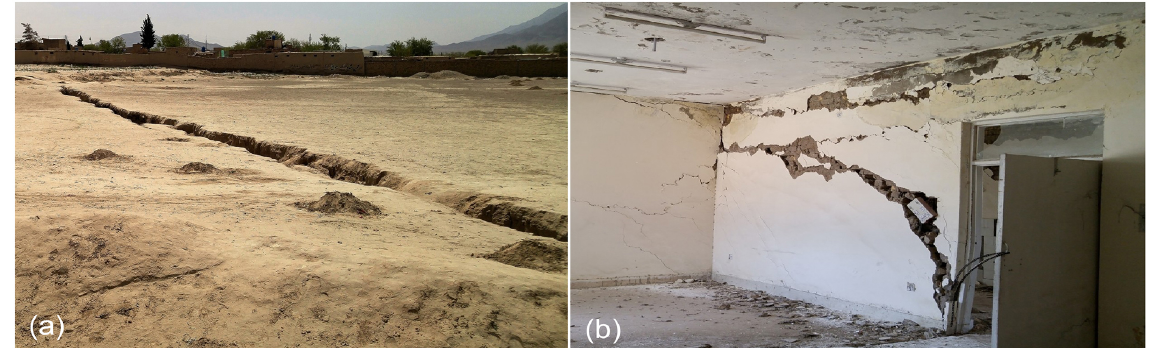
Figure 2. (a) shows the fissures in Kechi Baig area whereas (b) shows the damage that is caused to Dr. Sarfaraz hospital present on Gai khan